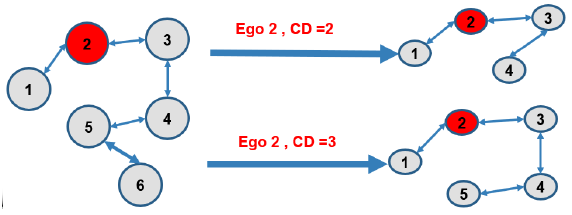
Figure 5. Ego social